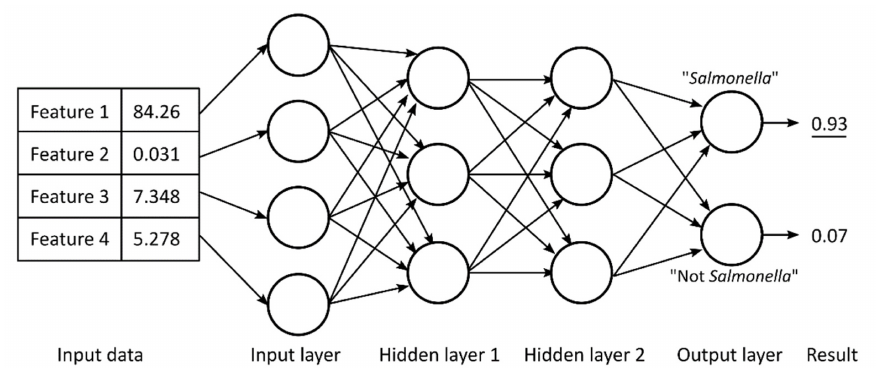
Figure 21. Multilayer artificial neural network showing 4 input neurons, 2 hidden layers made of 3 neurons, and 2 output neurons of which the one corresponding to “Salmonella” shows the highest value, associated with the prediction performed by the used ANN. Figure reprinted from Ref. [119] under the terms of the CC-BY license.